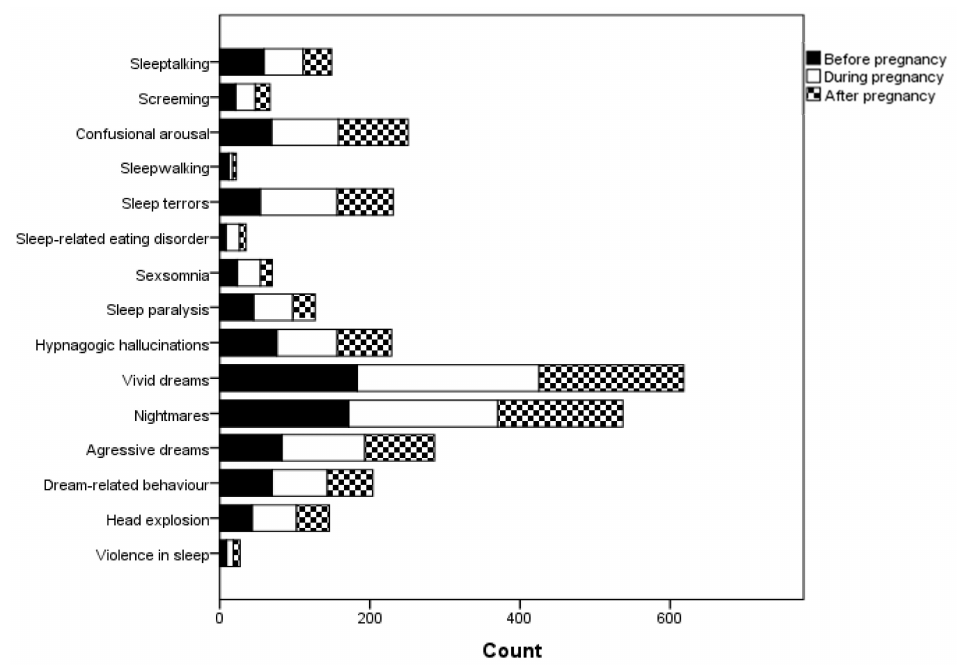
Figure 1. Representation of individual parasomnias in all the observed time periods.